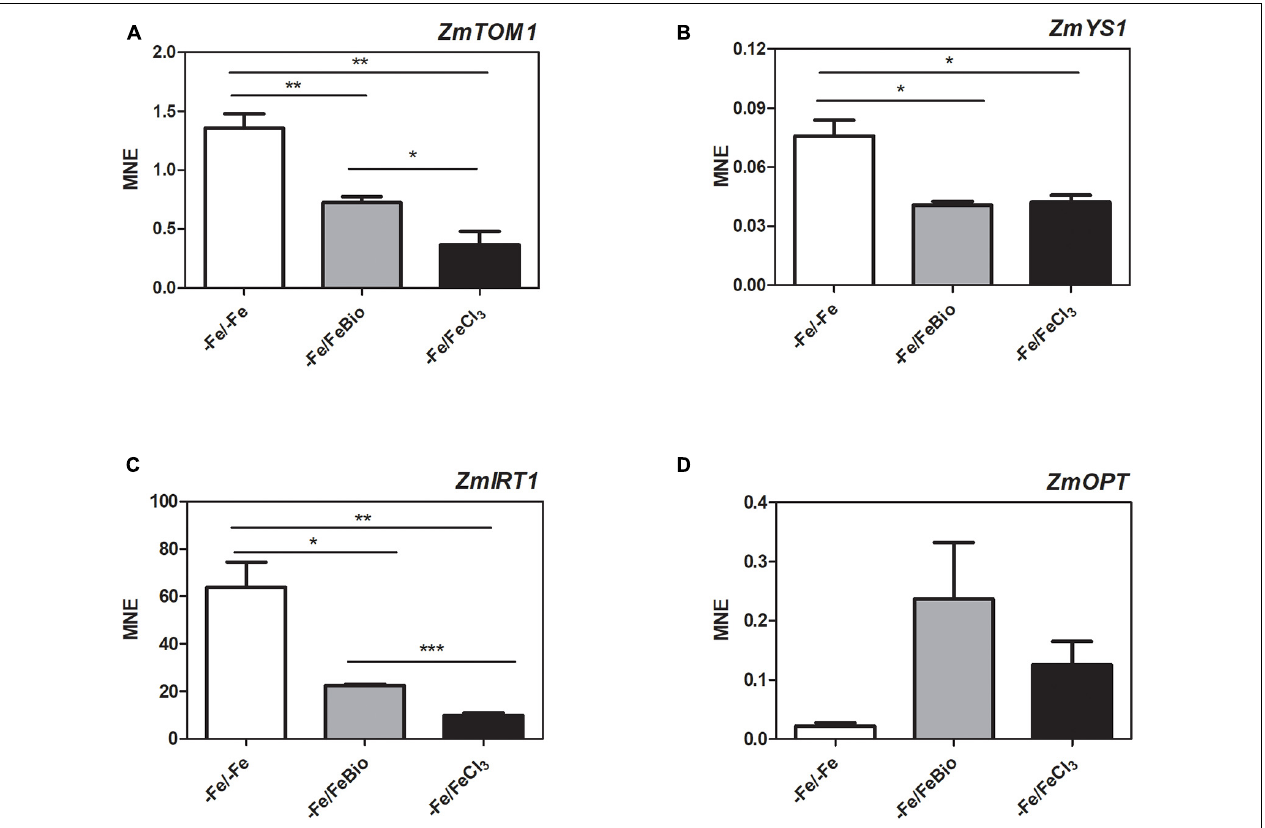
FIGURE 6 | Quantitative RT-PCR analysis of genes involved in Fe uptake in maize roots. Relative transcript level, calculated as Mean normalized expression (MNE) of ZmTOM1 (A) , ZmYS1 (B) , ZmIRT1 (C) and ZmOPT (D) was assayed in roots of plants grown under Fe-deprivation conditions (–Fe/–Fe) and after 24 h Fe-resupply either as FeCl 3 (–Fe/ + FeCl 3 ) or FeCl 3 plus PH (–Fe/FeBio). The values are the mean of three biological replicates. Bars represent the standard error (SEM). Student’s t -test was applied, * p < 0.05; ** p < 0.01; *** p <